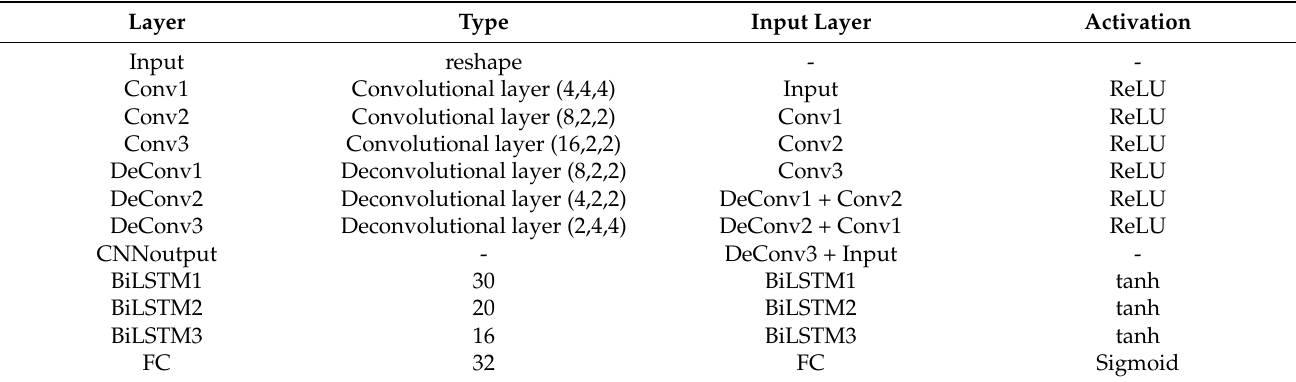
Table 2. Parameter settings of the proposed neural